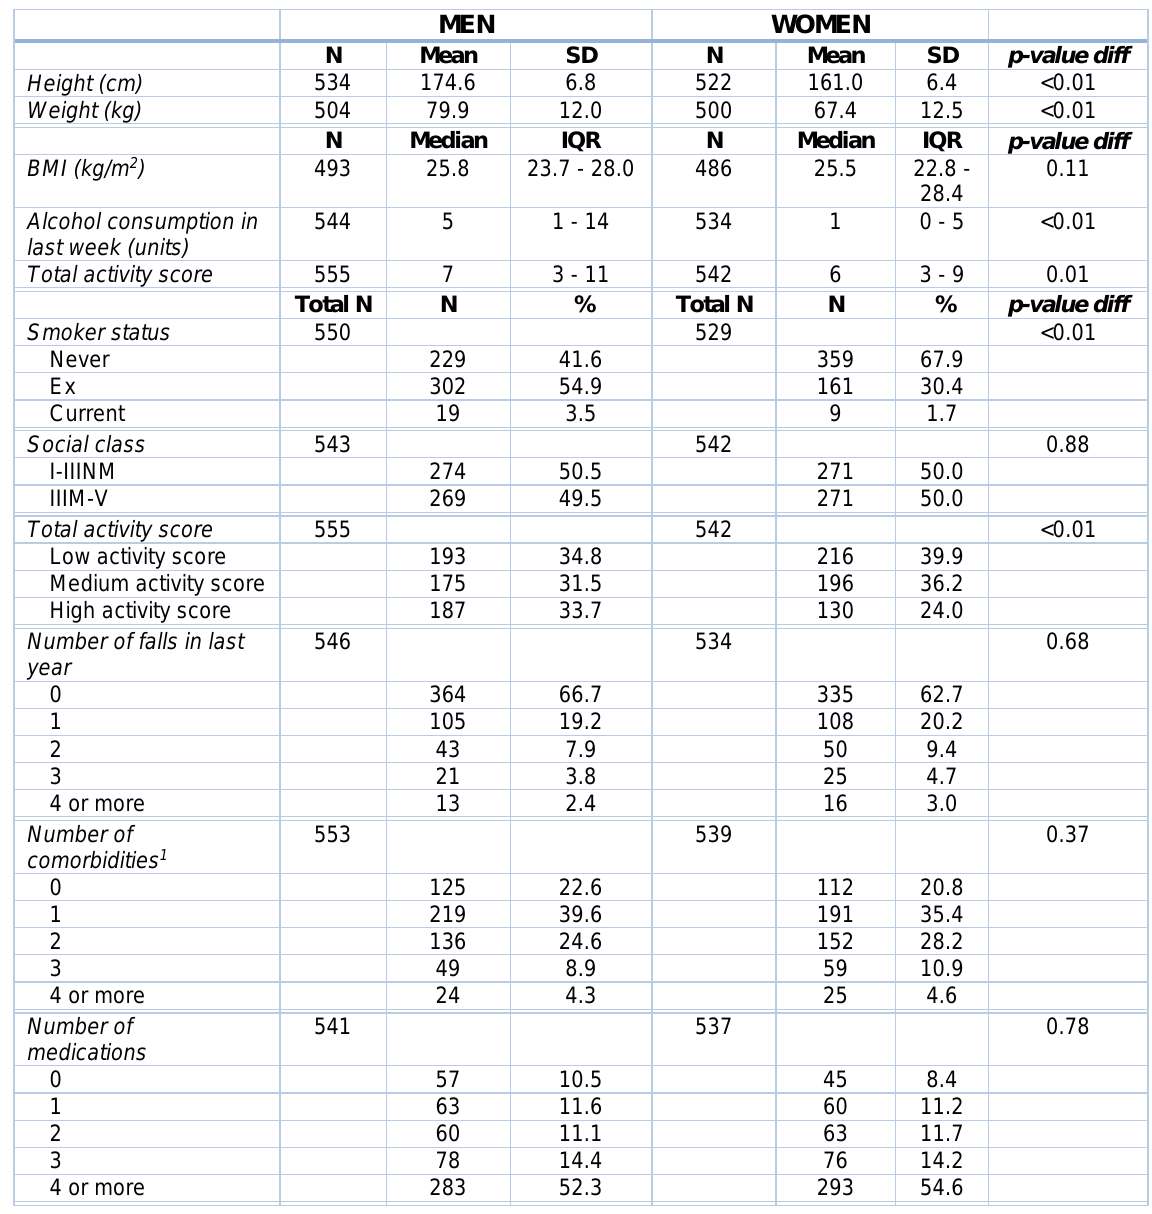
Table 1: Participants’